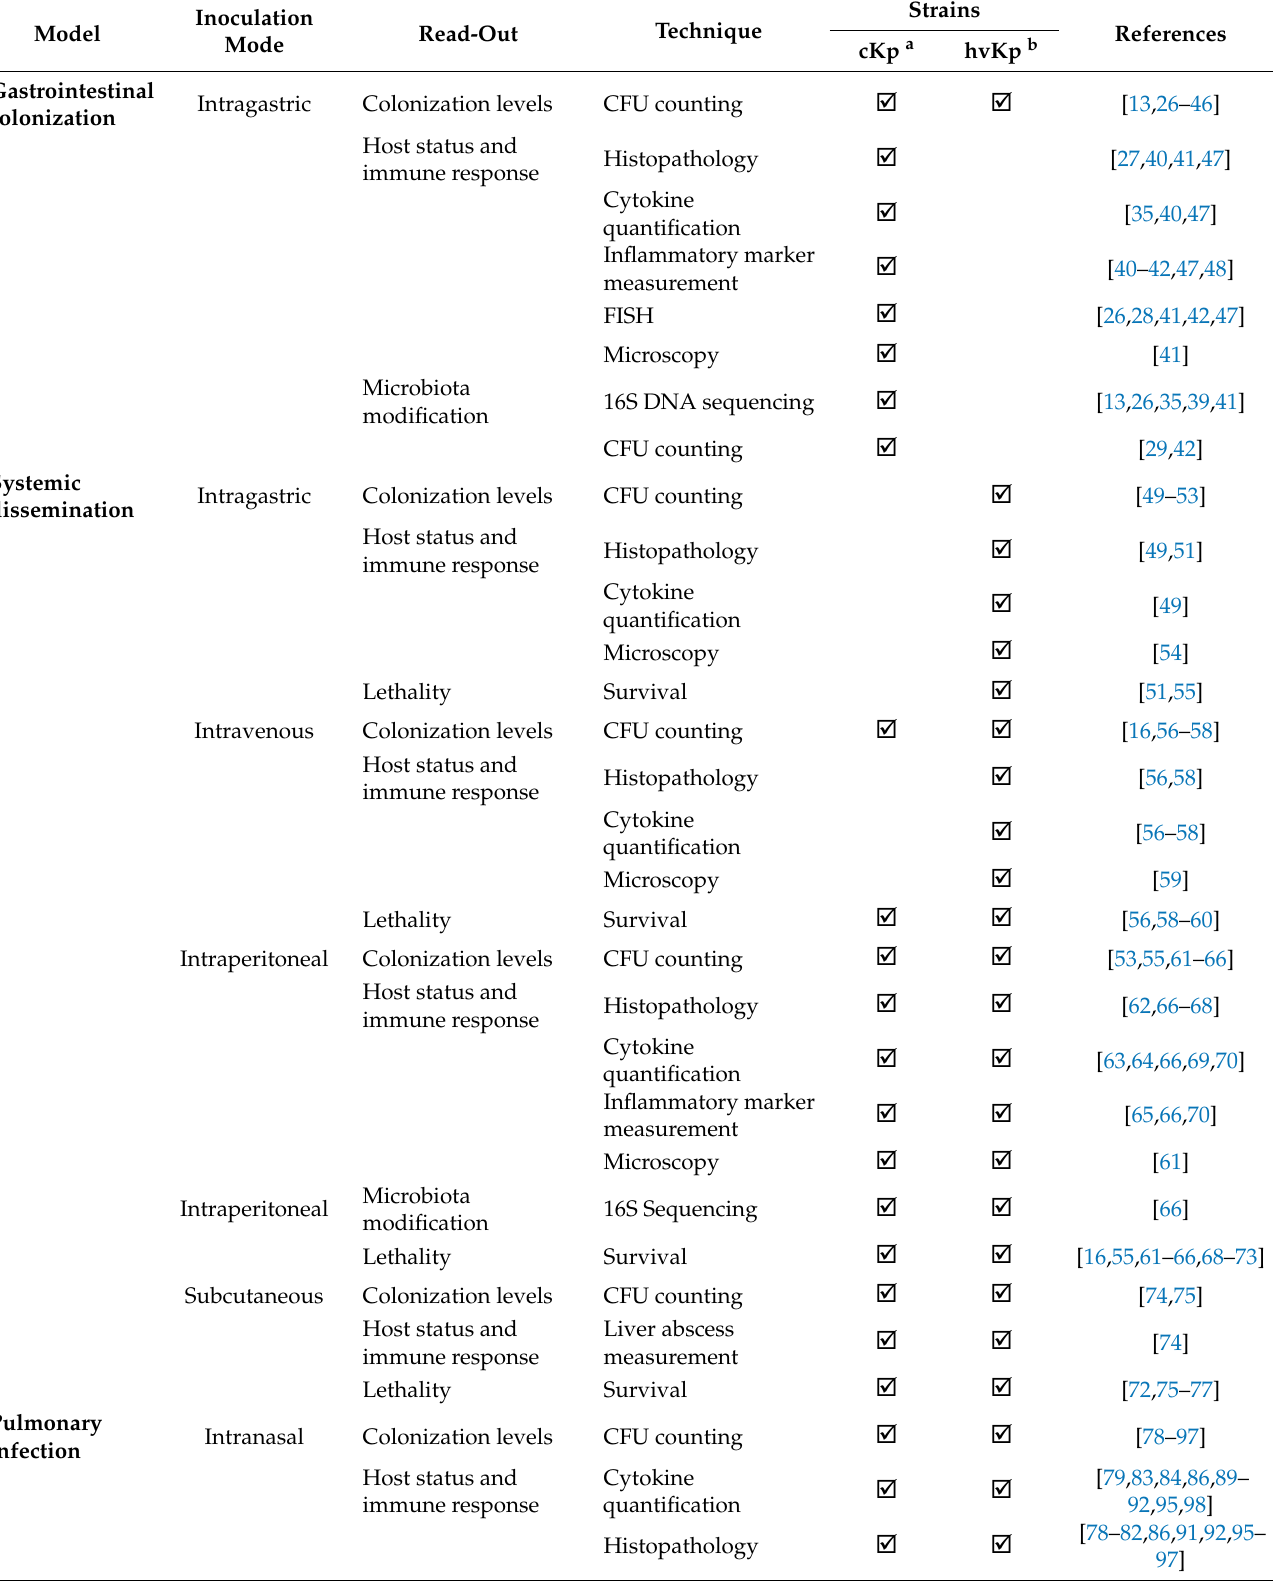
Table 1. In vivo investigated readouts in classical K. pneumoniae and hypervirulent K. pneumoniae . Model